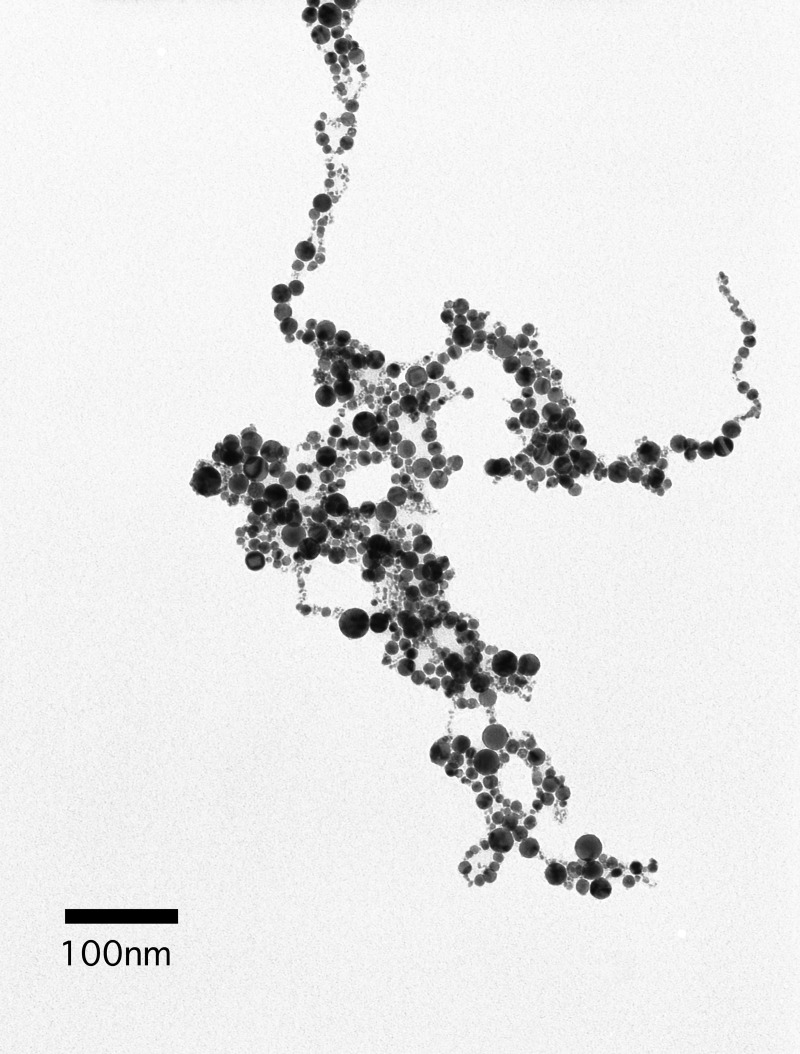
Transmission electron micrograph of PtNPs.10 ppm of PtNPs, which diluted by pure water were observed at 80kv 45μA. (scale bar = 100 nm) Nearly the same size of PtNPs as the manufacturer indicated (2-19nm) were observed.